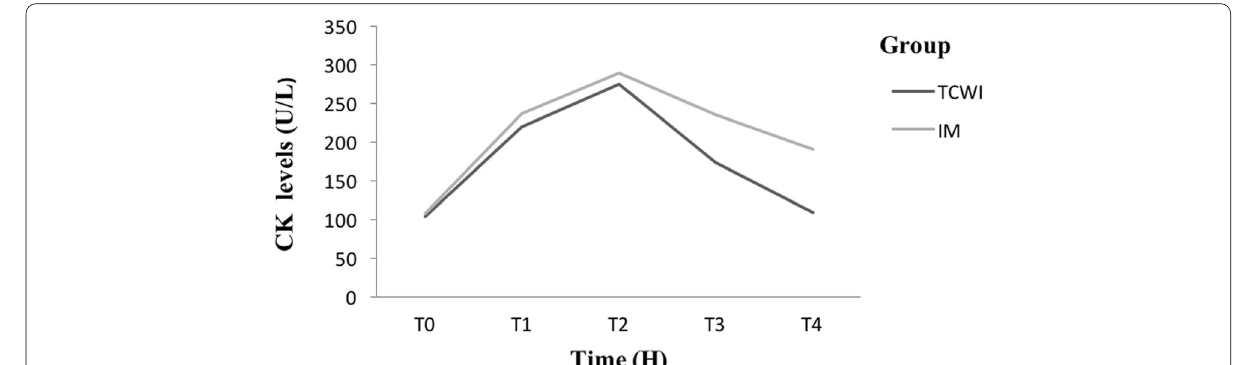
Fig. 1 Variation of creatine kinase’s activity between groups at different timelines